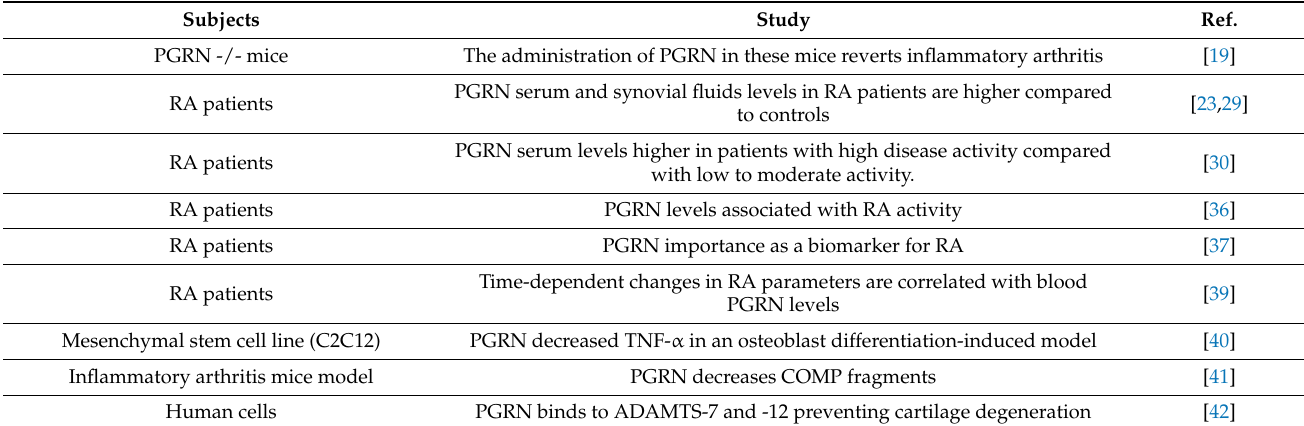
Table 1. Main findings in studies of PGRN in